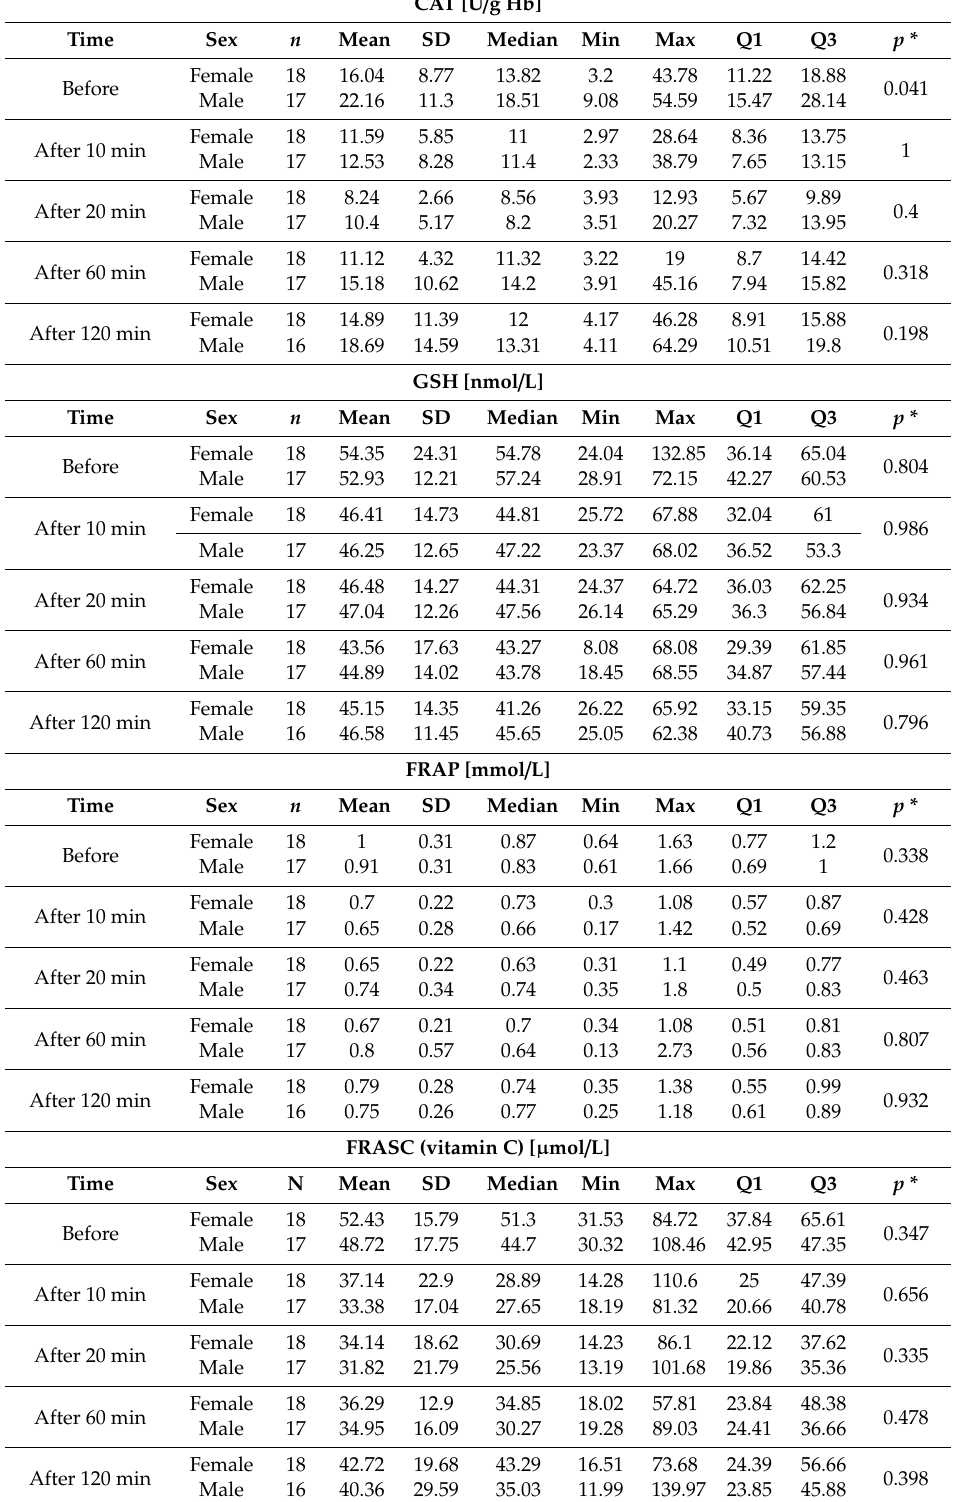
Table 5. The influence of sex on mean CAT, GSH, FRAP and FRASC values at di ff erent time points of the CT: before the test and 10, 20, 60 and 120 min after the